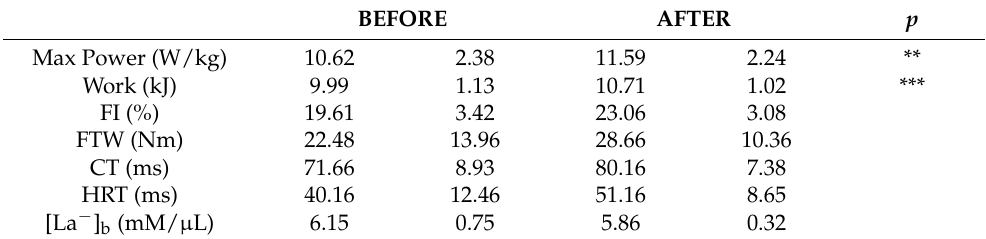
Table 2. Mechanical parameters, Twitch parameters, and Blood lactate. BEFORE AFTER p Max Power